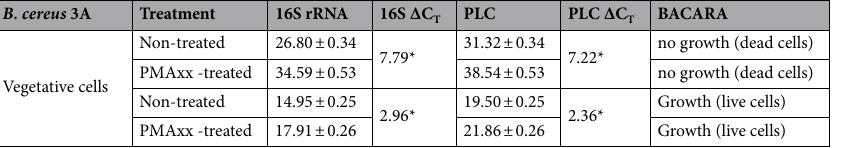
Table 5. Detection of viable cells of B. cereus 3A in in artificially contaminated liquid-type samples using multiplex PMAxx -qPCR and BACARA plates. *indicates a statistically significant difference ( P < 0.0001), Δ C T indicates the differences between PMAxx -treated and non-treated C T values. N: 3 trials.